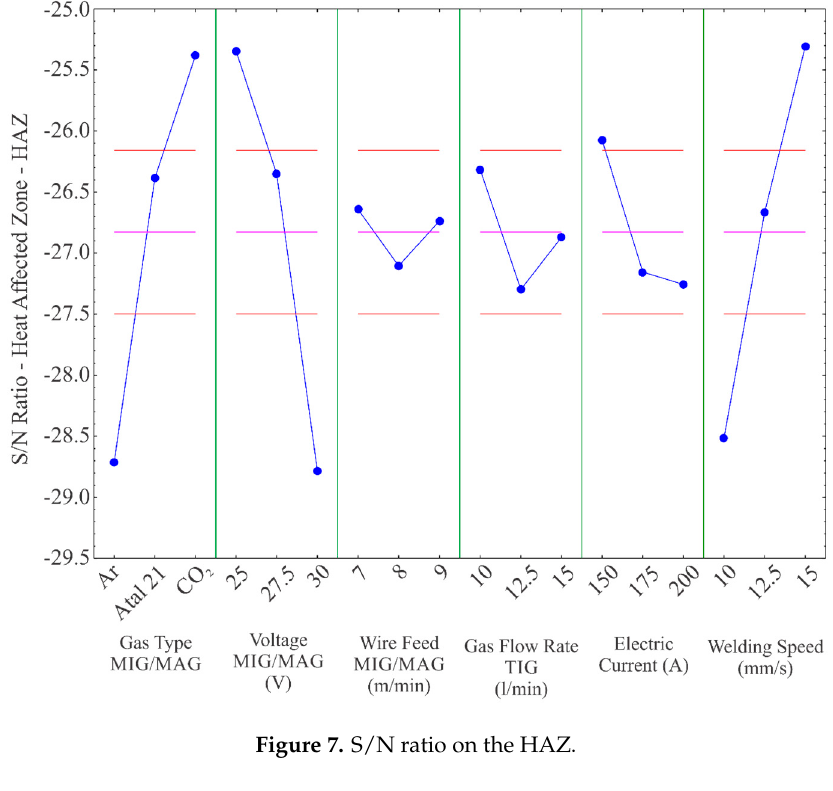
Figure 7. S/N ratio on the HAZ.